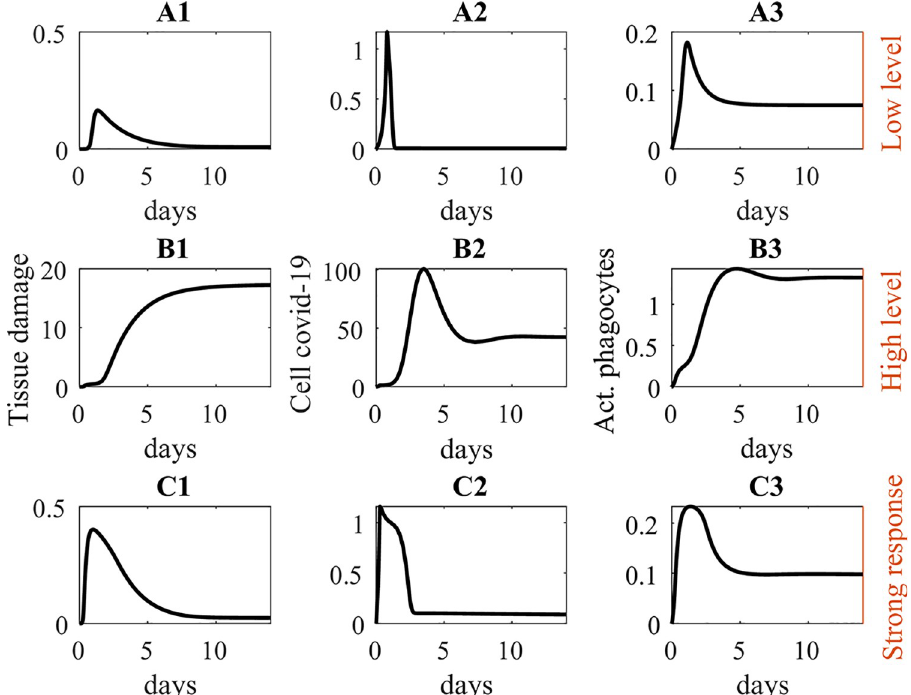
Fig 2. Model response to low level initial exposure to covid-19 (panels A1-A3) versus high level (B1-B3), and effect of a stronger immune response with high exposure level (C1-C3). Panels A1-C1, tissue damage (D). Recovery is possible at low exposure level (A1). High exposure level yields irrecoverable tissue damage (possibly death; B1), but recovery is possible if immune response is stronger (C1). Panels A2-C2, cellular SARS-CoV-2 level. Viral clearance is possible at low exposure level, or high level with a sufficiently strong immune response (A2 and C2), but clearance fails at high exposure level (B2). Panels A3-C3, inflammatory agents (e.g. activated phagocytes). Note different ordinate range for the B panels (nondimensional